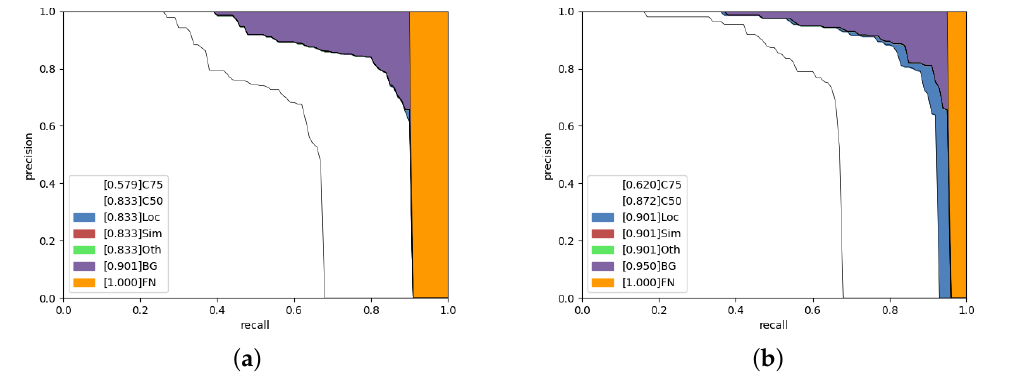
Figure 10. ( a ) HRNetV2p-HTC without OHEM, and ( b ) included. Small Objects are below 32 × 32 pixels. The area of the graph filled represents the proportion of the results for a given